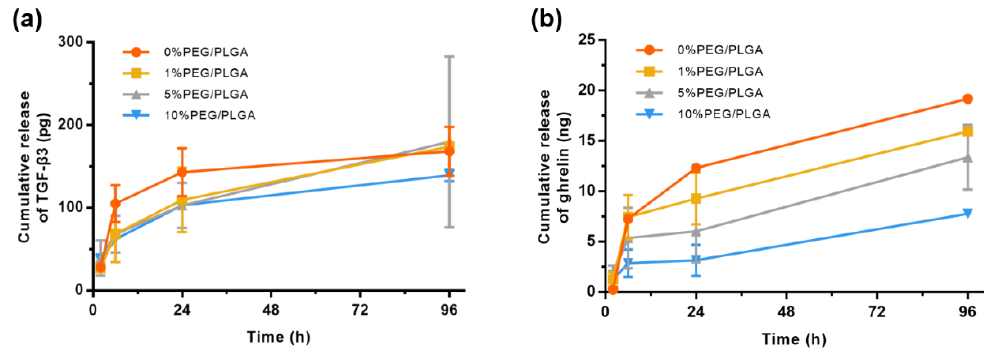
Figure 5. Study of the controlled release of TGF- β 3 and ghrelin in the microsphere/hydrogel system in vitro. In vitro release of TGF- β 3 ( a ) and ghrelin ( b ) from the microsphere/hydrogel system.